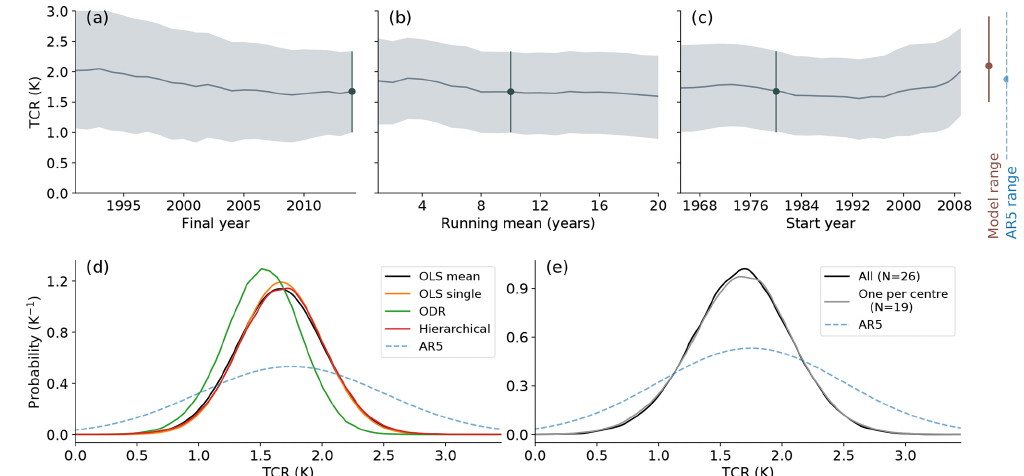
Figure 5. Robustness of the result to various parameter choices and the choice of regression method. Unless stated differently, start year is 1975, all years up to 2018 are used, and the length of the running mean is 11 years. For comparison, the 5%–95% model range and IPCC range are shown, both assuming normal distributions. Panel (a) : 5%–95% TCR range as a function of the final year (blue line central estimate). Panel (b) : 5%–95% TCR range as a function of the length of the running mean. Panel (c) : 5%–95% TCR range as a function of the start year. Panel (d) : pdf of TCR from different regression methods. The hierarchical Bayesian model is compared to three other linear regression methods used in the emergent constraint literature: ordinary least squares (OLS) with only one realisation per model and OLS on the mean warming per model and orthogonal distance regression (ODR). (e) Resulting pdfs on TCR from stricter model selection (one model per modelling centre) compared to regression using all models and the IPCC AR5 range.